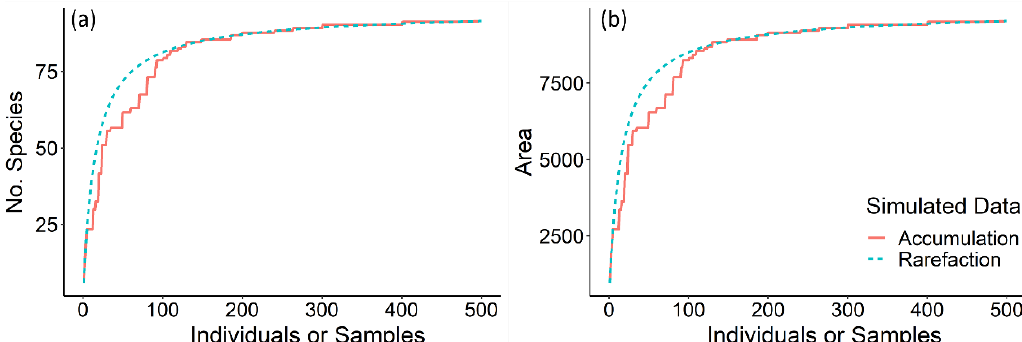
Figure 1. Examples of simulated graphs showing contrasting patterns between accumulation and rarefaction methods when using di ff erent sample sizes for ( a ) number of species observed and ( b ) estimated extent of fishing. Both simulated datasets exhibit an asymptotic (leveling o ff ) behavior. Beyond that point collecting additional samples (species or maps) does not lead to new information on the total number of species or maximum extent of human activities.